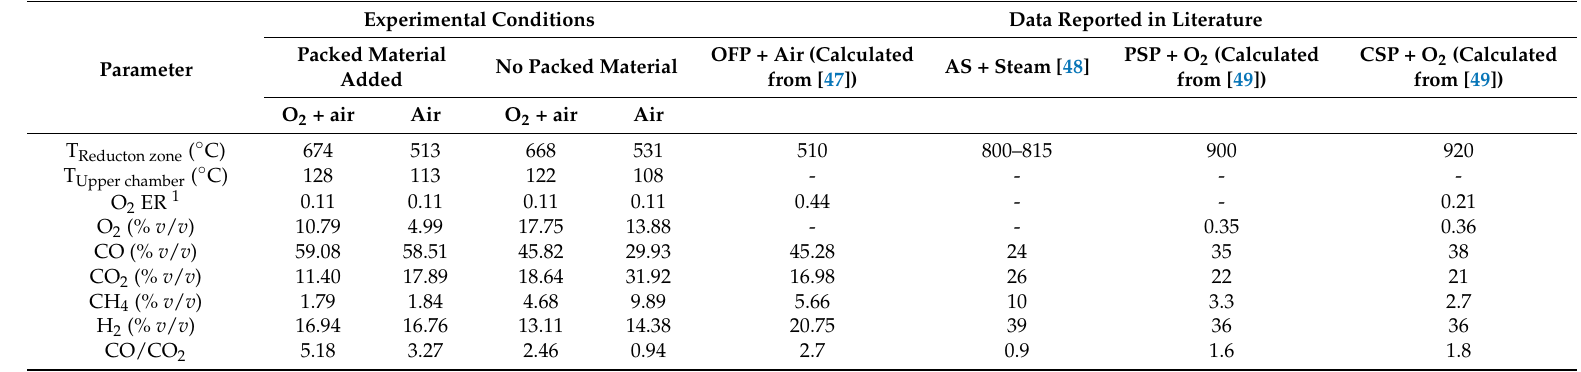
Table 9. Syngas composition, CO/CO 2 ratio, and operational temperature